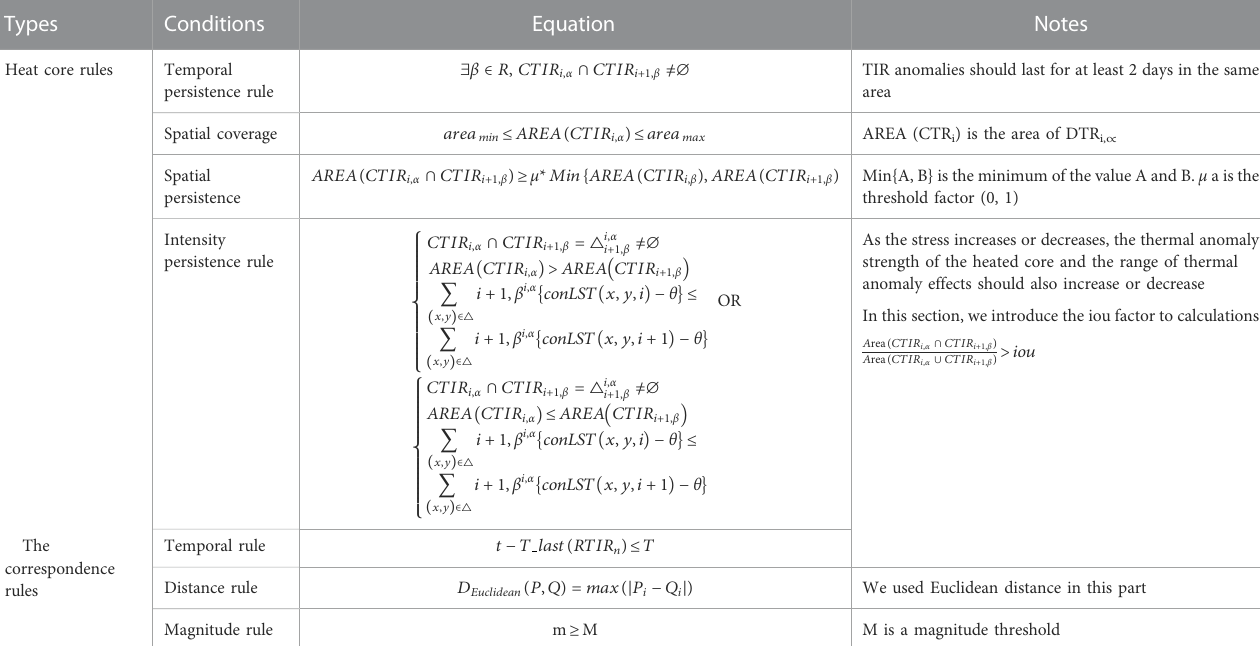
TABLE 2 The rules include rules for heating core model and rules for determining whether it is related to earthquakes.